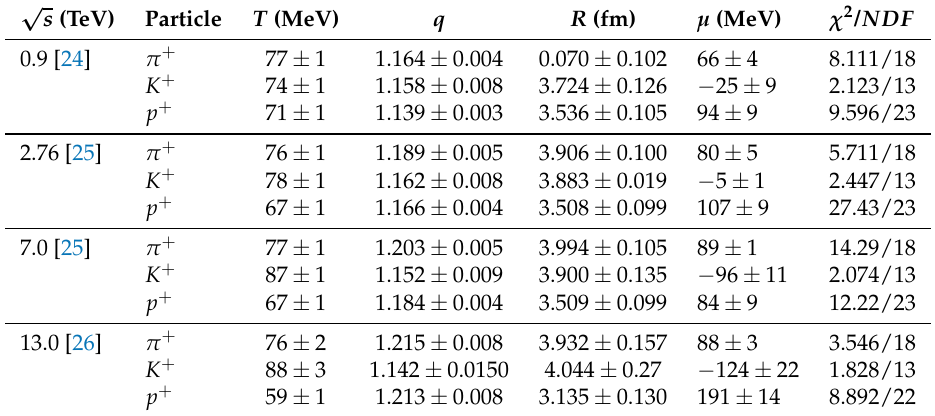
Table 3. The extracted values of T , q , R , µ and χ 2 / NDF parameters, using the data published in [24–26] for pp collisions with the CMS experiment. √ s